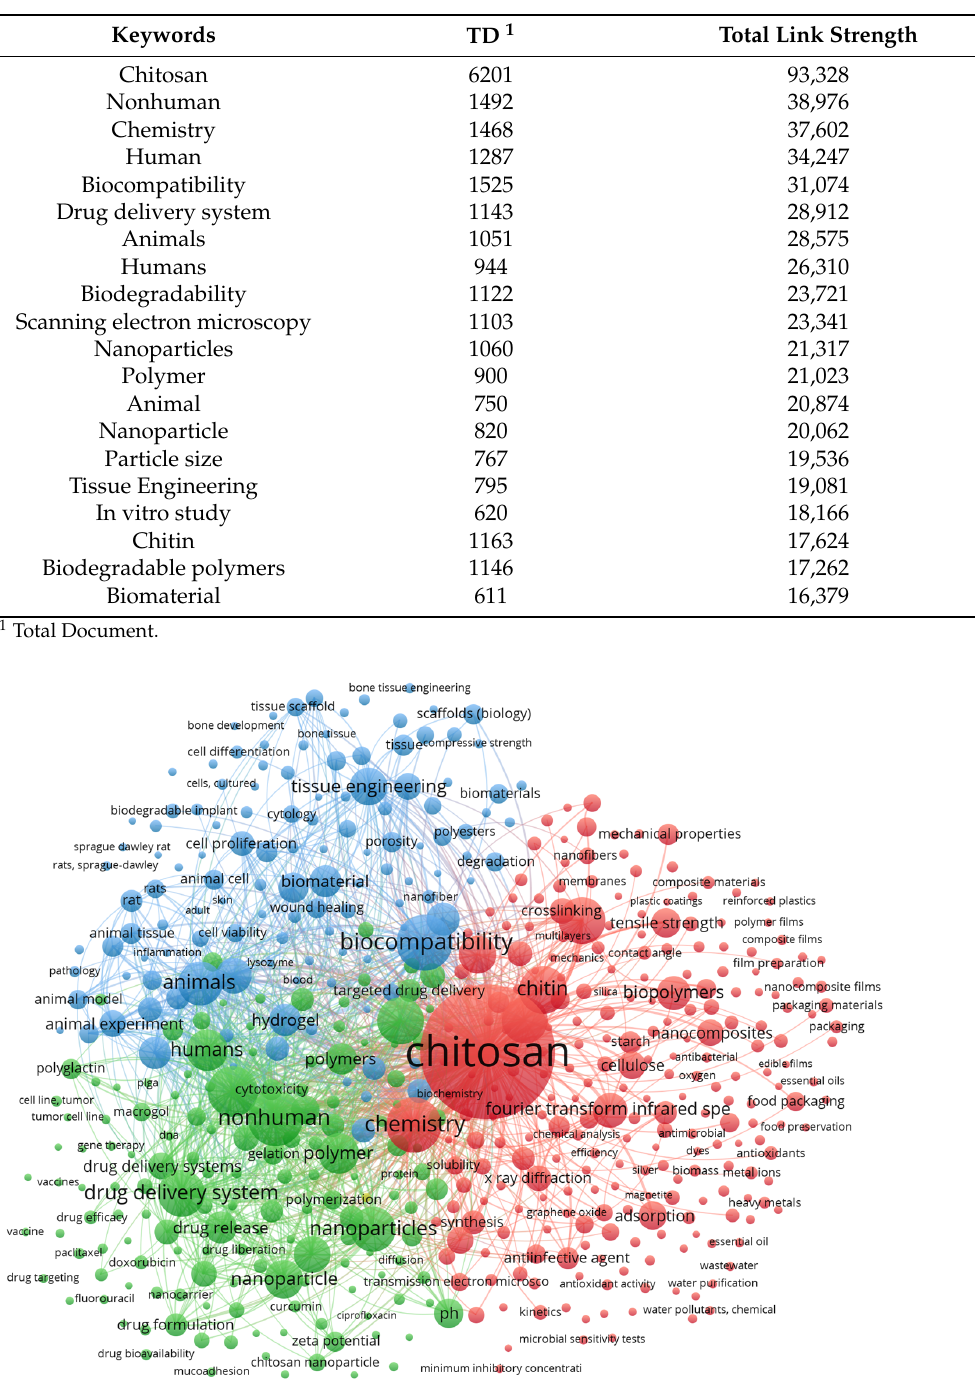
Figure 5. Keyword co-occurrence map.